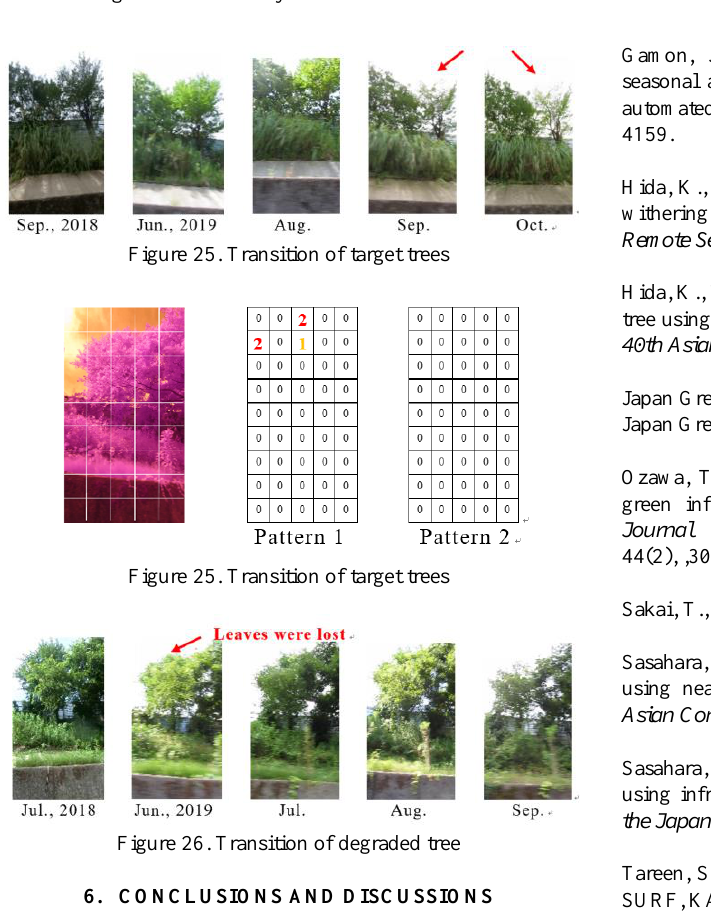
Figure 24. NDVI/day from June to October